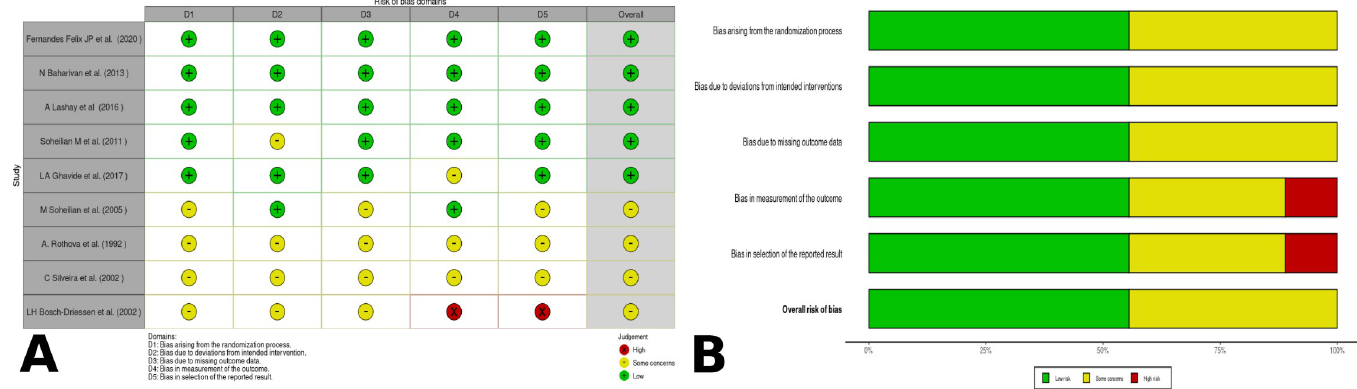
Fig 2. Risk of bias summary across randomized controlled trials using version 2 of the Cochrane risk-of-bias tool for randomized trials (RoB 2) [19]. (A). RoB2 risk of bias summary of randomized control trials traffic light; (B). Risk of bias graph across randomized controlled trials.